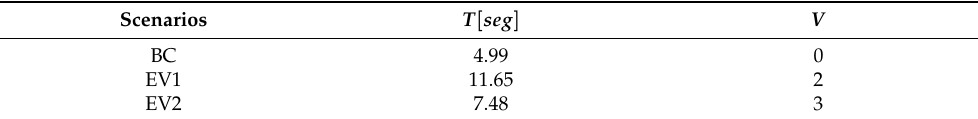
Table 5. Operating time and coordination violations for scenarios without